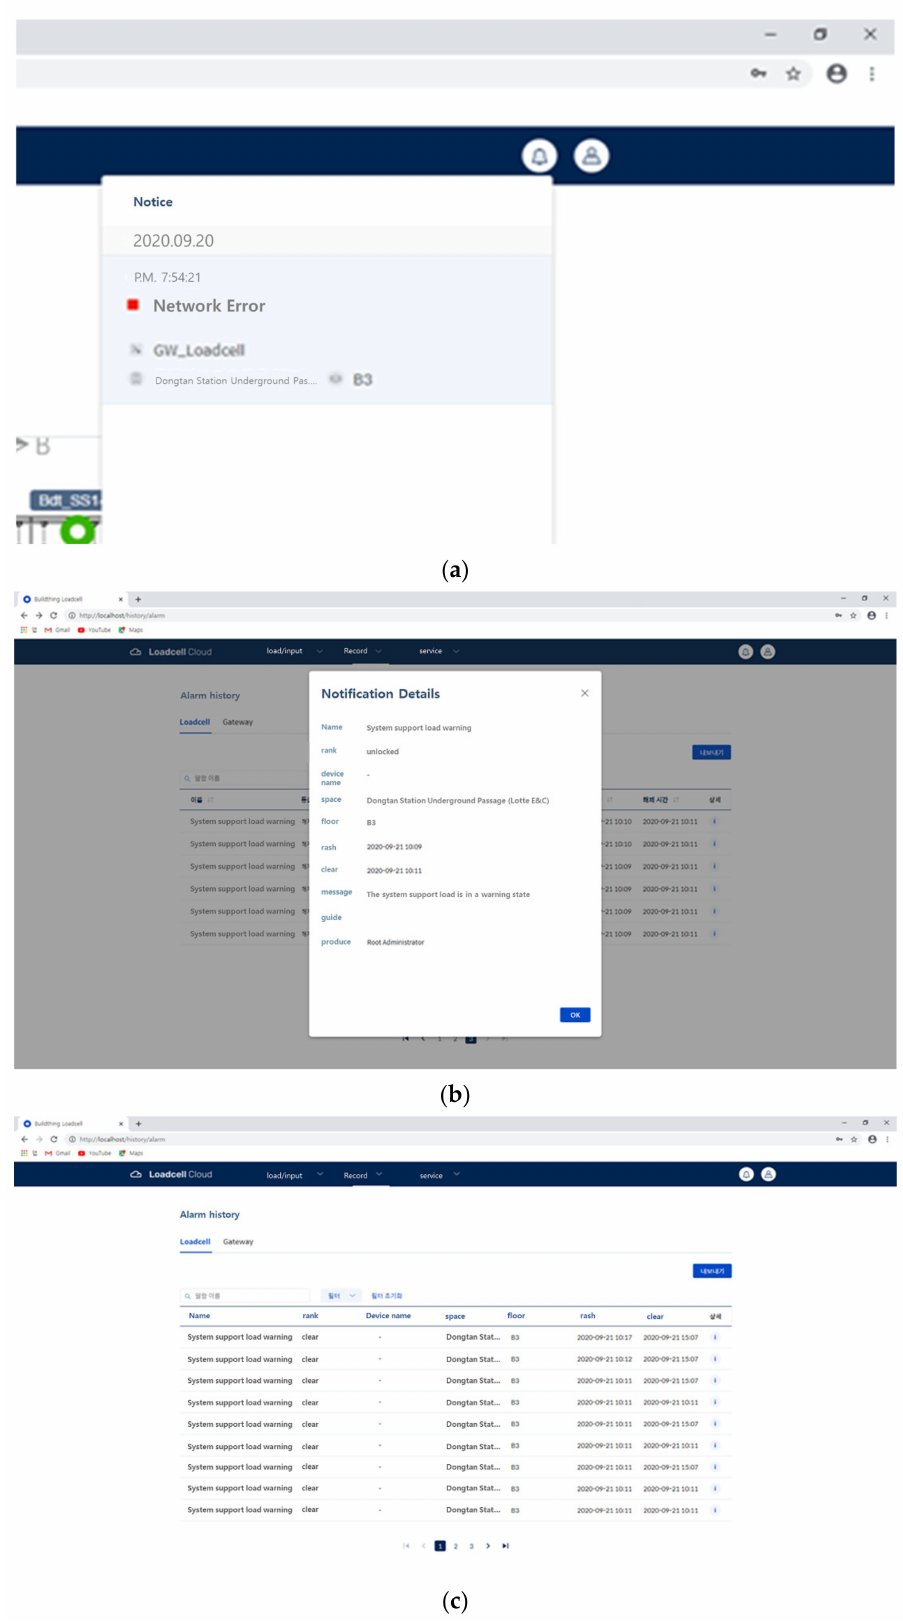
Figure 20. Monitoring screens ( a ) Notification push; ( b ) categorization of notification history; ( c ) viewing notification